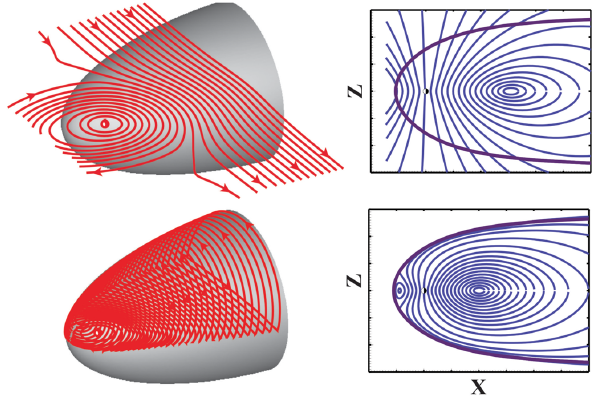
Fig. 1. (Top) Unbounded currents (red) and unshielded B field lines (blue). (Bottom) Adding the shielding field results in current closure via the magnetopause (grey shading) and fully confined magnetic